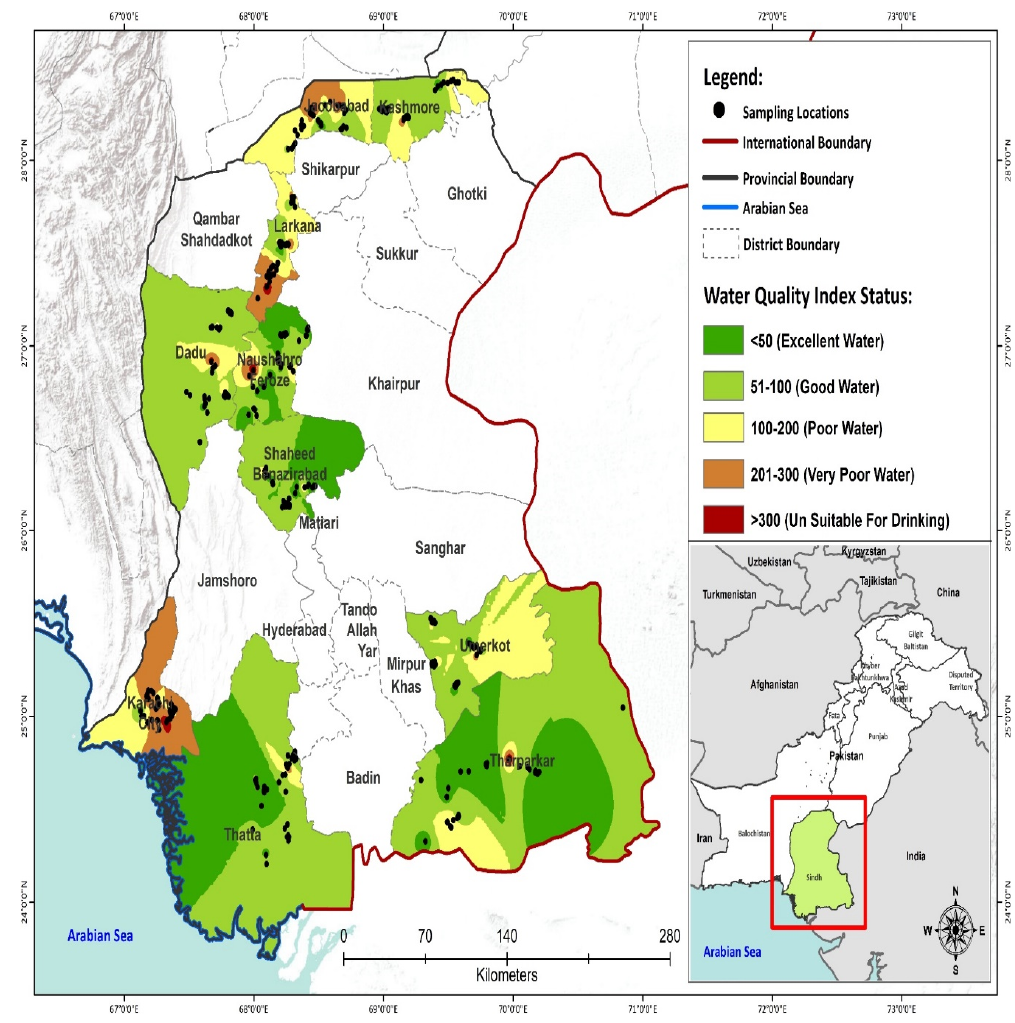
Figure 4. Water Quality Index of the primary schools of Sindh.